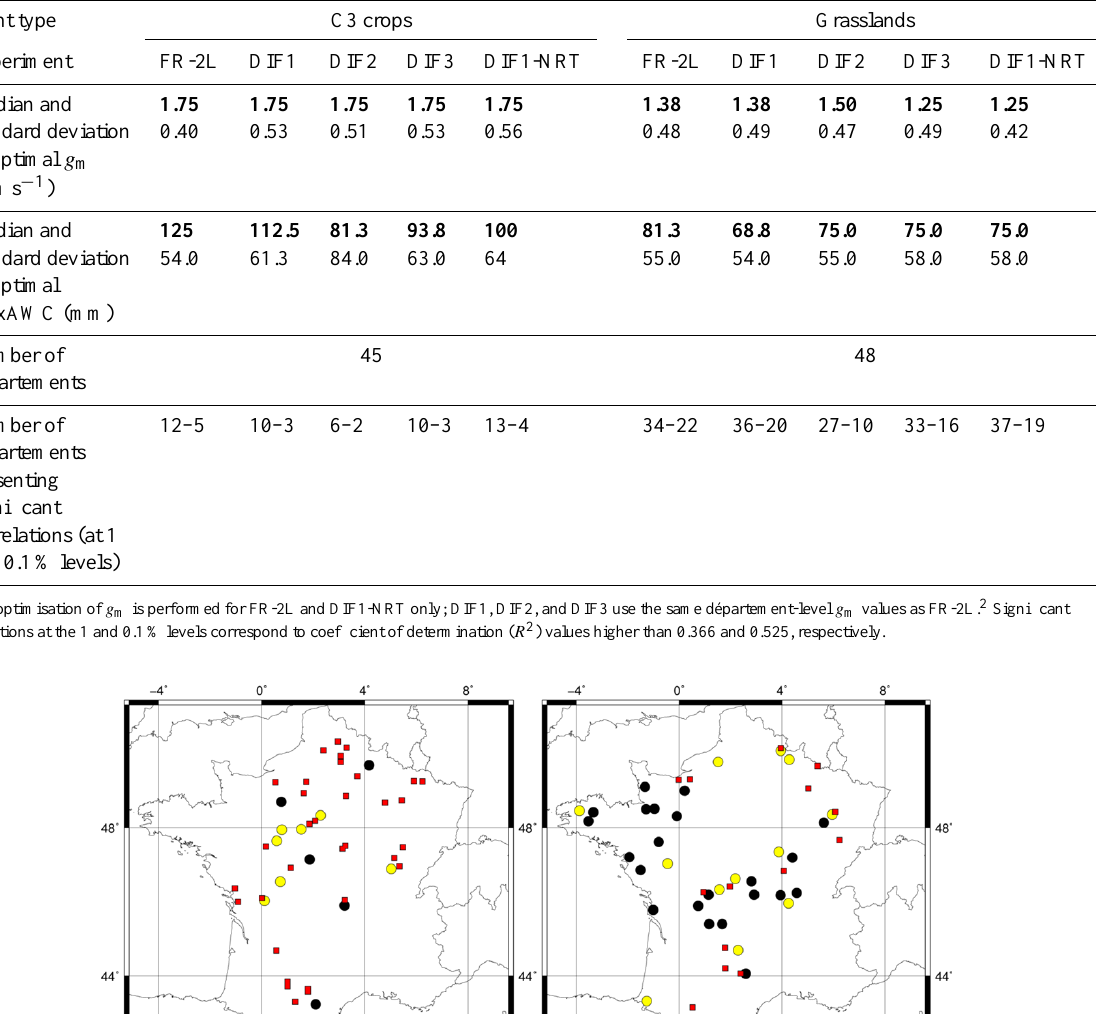
Table 2. Median MaxAWC value and median g m value under well-watered conditions, derived for each experiment ( 1 ) and number of départements where the simulated B ag presents significant correlations ( 2 ) with the annual yields of Agreste statistics for six cereals (winter X wheat, rye, winter barley, spring barley, oat and triticale) and for permanent grasslands in France over the 1994–2010 period. Median values are in bold.